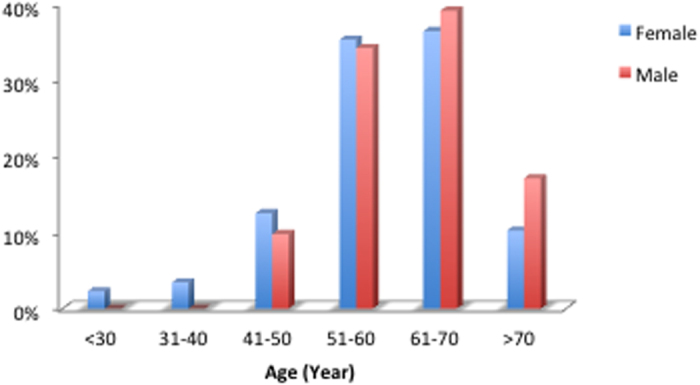
The age distribution of the 129 MPLC patients analyzed.